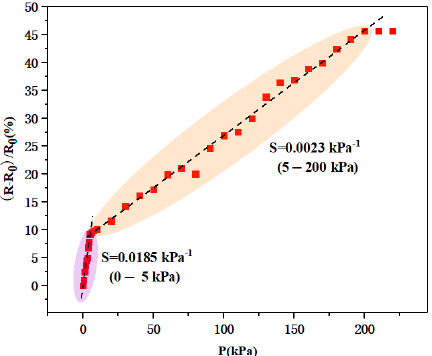
Figure 6. The sensitivity curve for the flexible pressure sensor based on silicon nanomembranes.